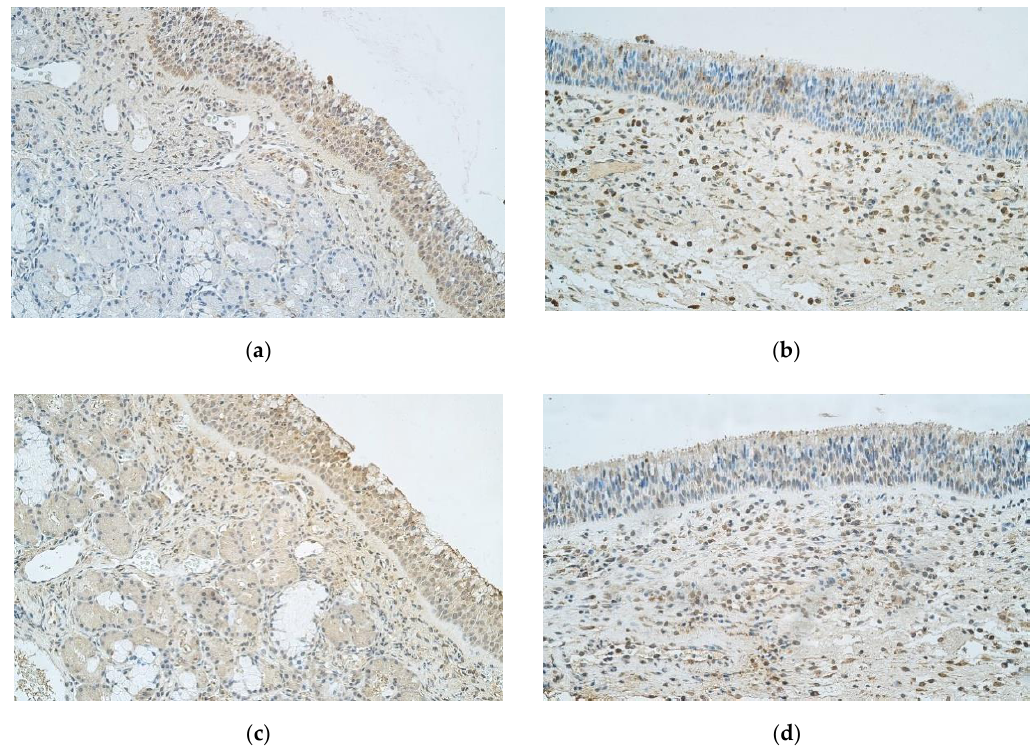
Figure 2. ( a – d ) Immunohistochemical micrographs of patients with nasal polyps and control subjects. ( a ) 42-year-old male with healthy nasal mucosa. Note moderate to numerous IL-1 α positive structures in epithelium as well as occasional positive structures in connective tissue of the control sample of normal nasal mucosa and large amounts of